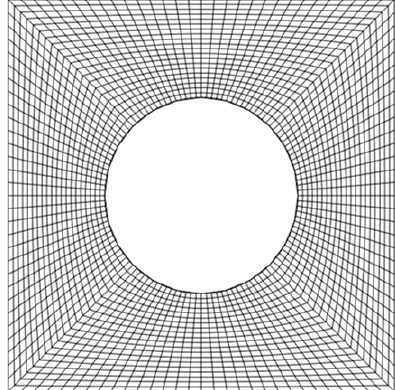
Figure 3. Mesh scheming in FEM.